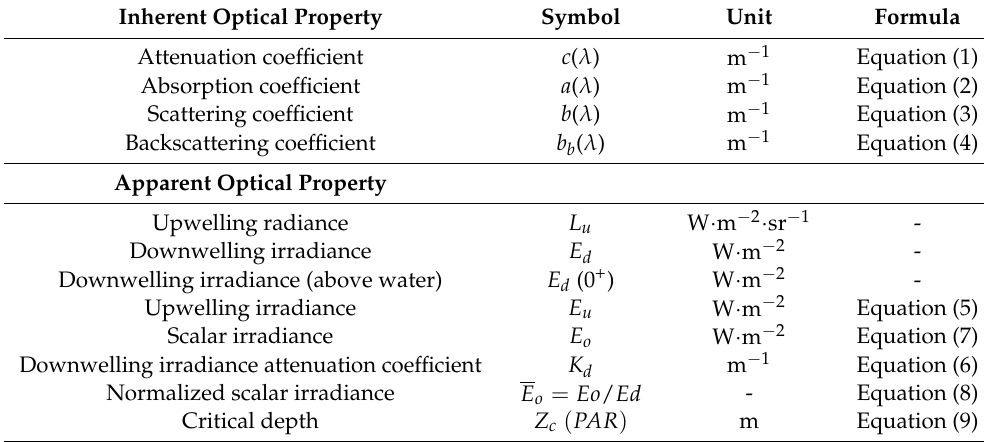
Table 1. Compilation of all optical parameters used in this paper, including respective symbol, unit, and calculation formula. Inherent Optical Property Symbol Unit